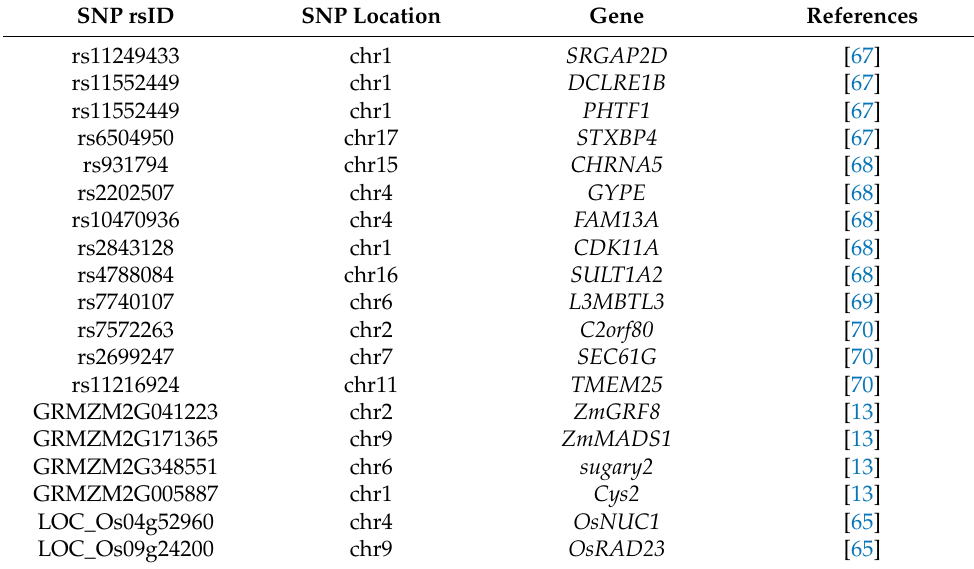
Table 2. Summary of GWAS-associated